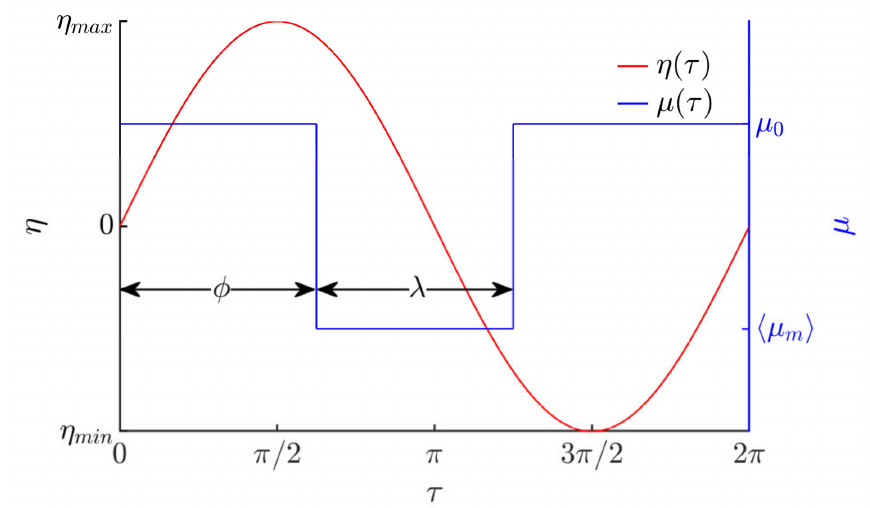
Figure 2. Dry friction control in respect of the period of the harmonic